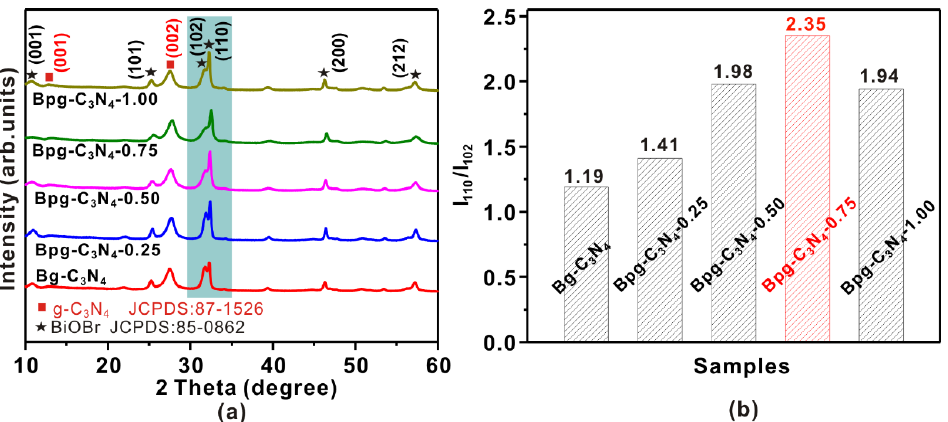
Figure 1. ( a ) XRD patterns and ( b ) the diffraction intensity ratio of (110)/(102) planes of Bg-C 3 N 4 and Bpg-C 3 N 4 -X samples (X is the amount (in mL) of HCl added in the protonation treatment of g-C 3 N 4 ; X = 0.25, 0.50, 0.75, 1.00).